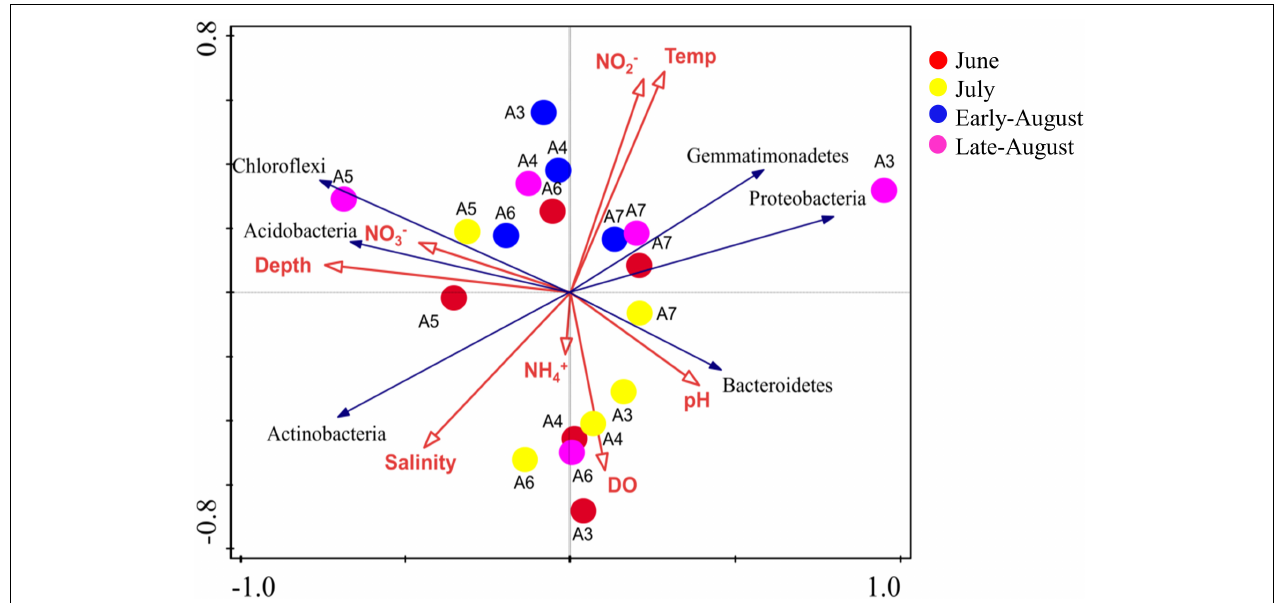
FIGURE 5 | Redundancy analysis (RDA) shows the relationship between environmental variables and the bacteria communities.